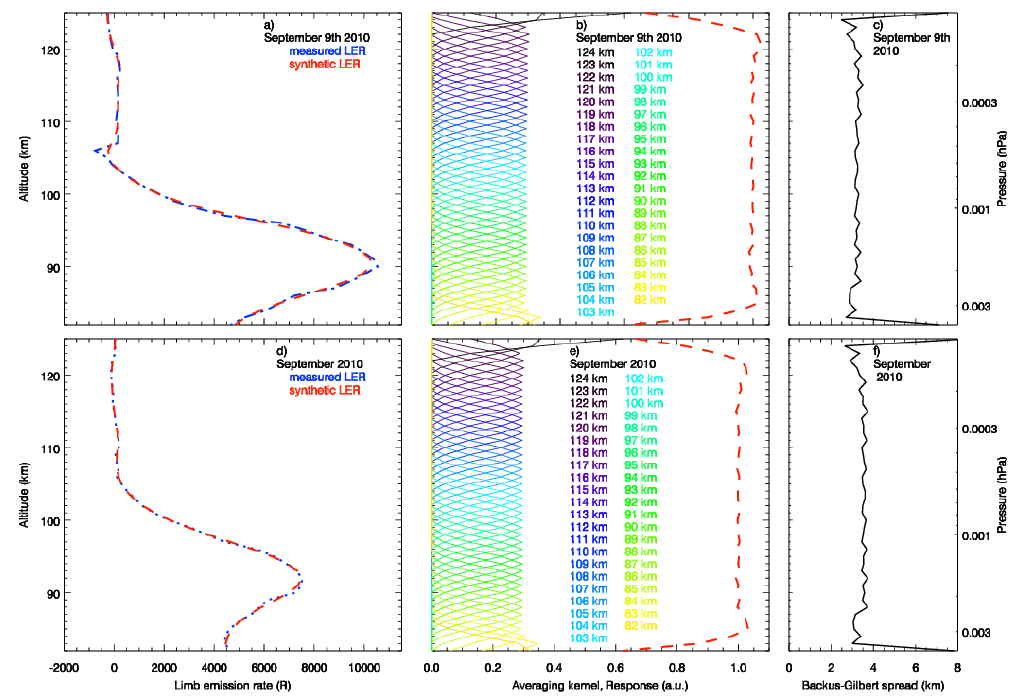
Figure 5. Characteristics and diagnostics of the inversion procedure in sample daily (top row) and monthly averages (bottom row) for the latitude range 20–25 ◦ N: comparison of the measured LER profile and the synthetic LER profile (panels a and d ); averaging kernel and the resulting area (response curve marked red) (panels b and e ); the vertical resolution (Backus–Gilbert spread) (panels c and f ).